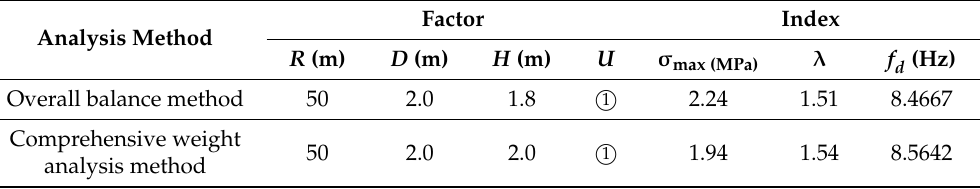
Table 11. Mechanical properties with different optimal